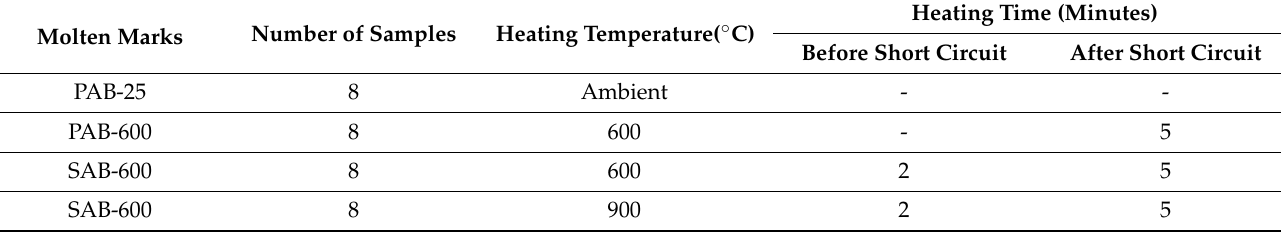
Table 1. The experimental conditions for the fabrication of the molten marks. Heating Time (Minutes) Molten Marks Number of Samples Heating Temperature( ◦ C) Before Short Circuit After Short